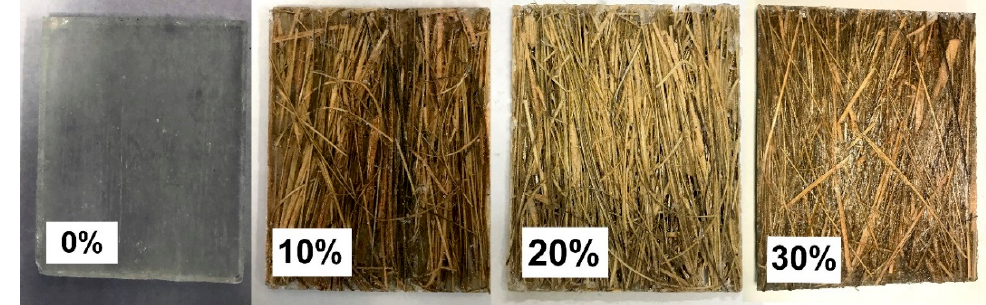
Figure 2. Composite plates of epoxy resin reinforced with caranan fiber.